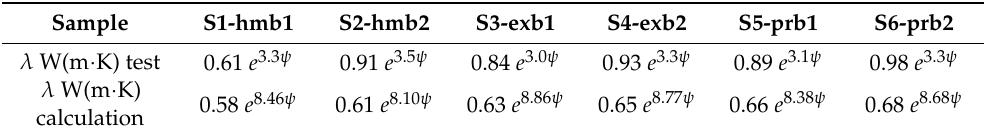
Table 7. Correlation formulas for thermal conductivity as a function of water content in the different types of bricks.